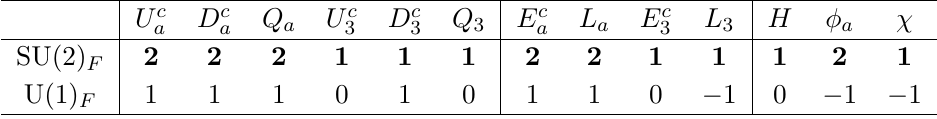
Table 4 . The U(2) F quantum numbers of the SM fermions and the scalars H , φ a and χ in the example LFV axiflavon